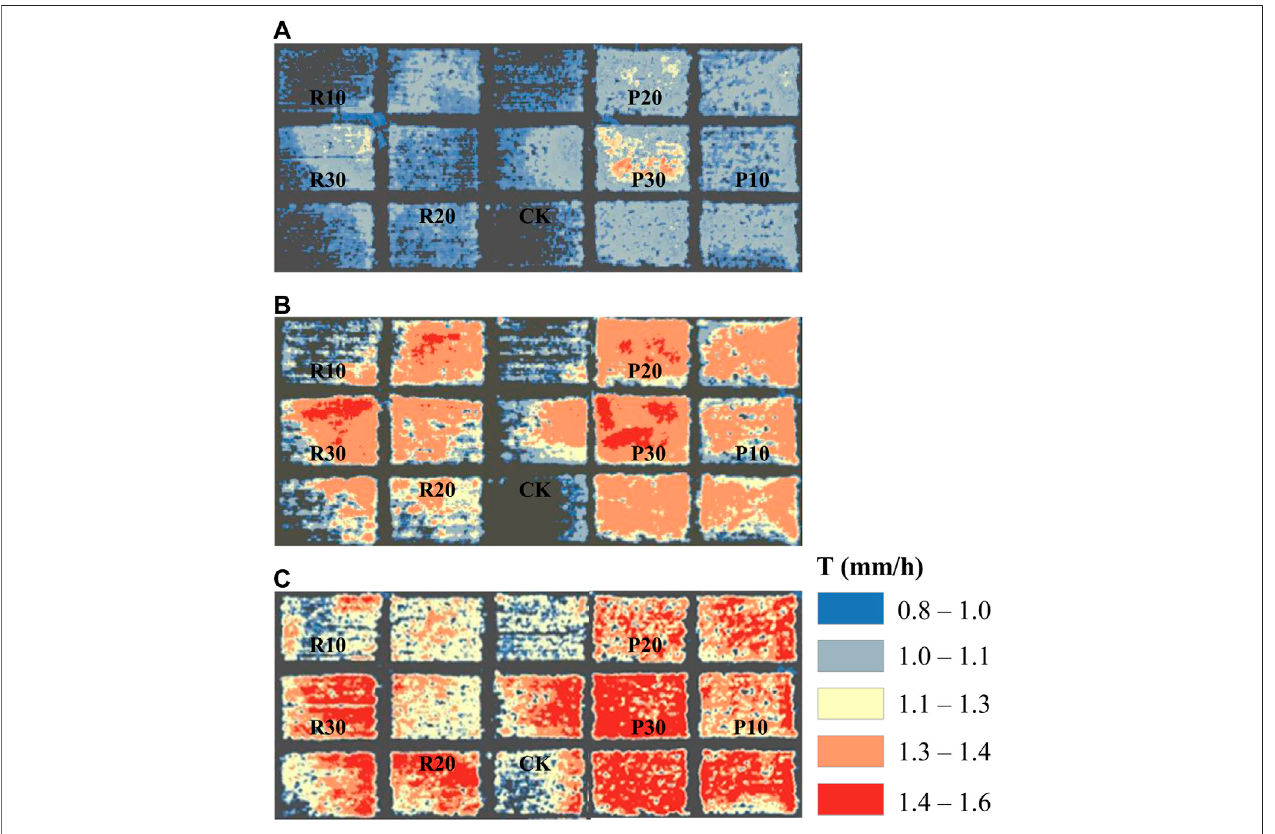
FIGURE 5 | The transpiration rates of alfalfa based on UAV monitoring for the (A) nutritional growth stage, (B) transitory stage, and (C) reproductive growth stage. The images were collected at 13:00 on July 21, July 30, and August 19, 2018. The brown pixels in each fi gure are soil which was not considered in this study.